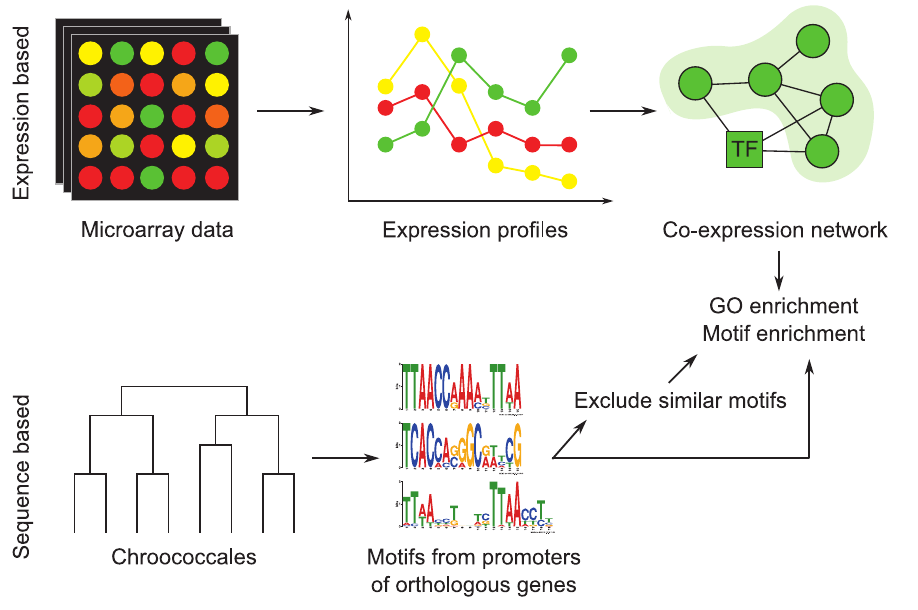
Figure 1. Overview of the data and methods used in the study. A co-expression network was inferred from gene expression, and promoter motifs were identified de novo from the genome sequences of orthologous species. The motif information was used to investigate if transcription factor neighborhoods were enriched for motifs compared to random network neighborhoods.